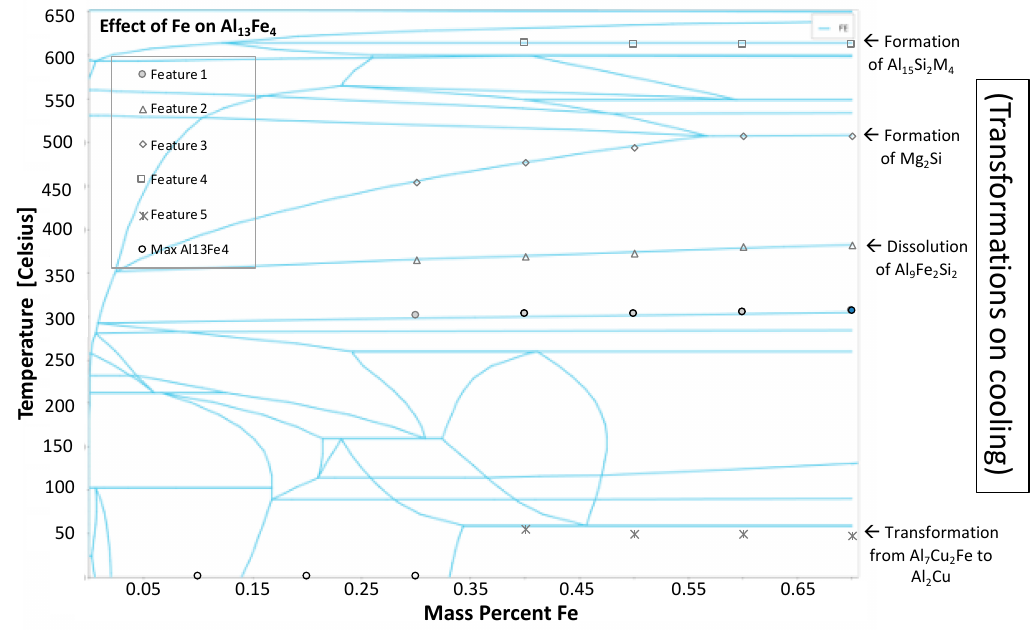
Figure 28. Equilibrium isopleth of Al 6061 with varying amounts of iron. Features 1–5 are corresponding to the behavior of equilibrium phases shown in the previous figure.